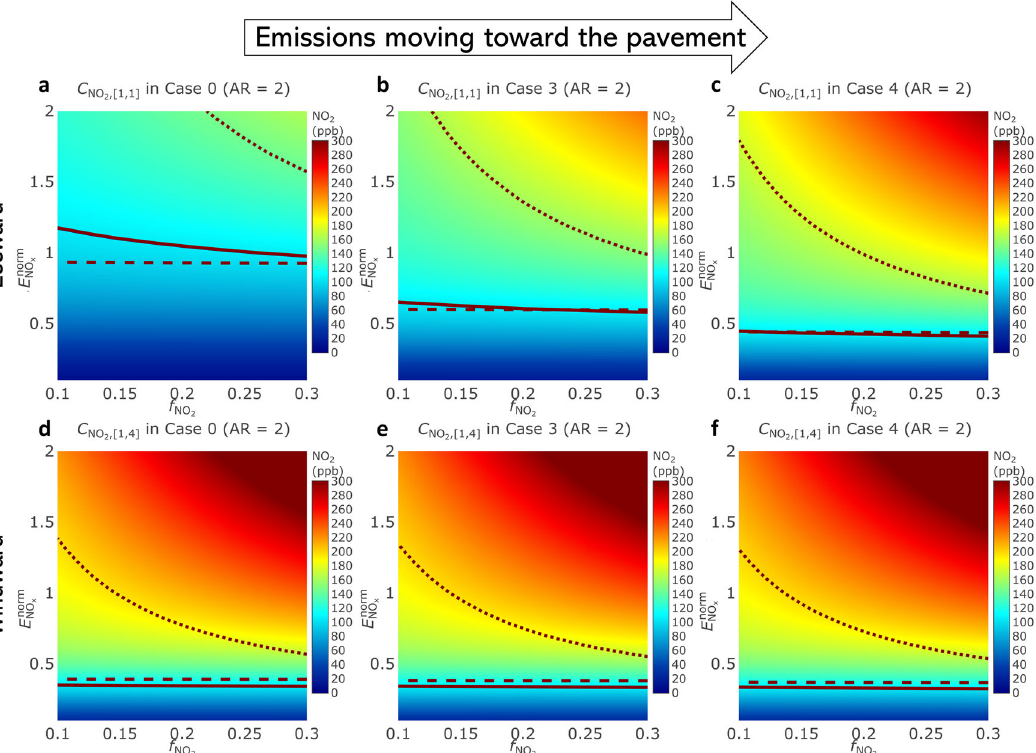
Fig. 3 Emission heterogeneities on NO 2 mixing-ratios in the deep canyon. The mixing-ratios (ppb) of NO 2 on the leeward side ( C NO ) and 2 ,[1,1] ¼ 1 under different emission heterogeneities. f norm ) of the deep canyon at E norm windward side ( C NO NO 2 is the primary NO 2 fraction, and E VOCs NO x 2 ,[1,4] is the ratio of NO x emission rates to the TEC of a typical emission condition. The solid line represents the UK air quality hourly NO 2 limit changes to 0.1 and 2, (105 ppb), and this contour line shifts to the dotted and dashed lines when E norm VOCs